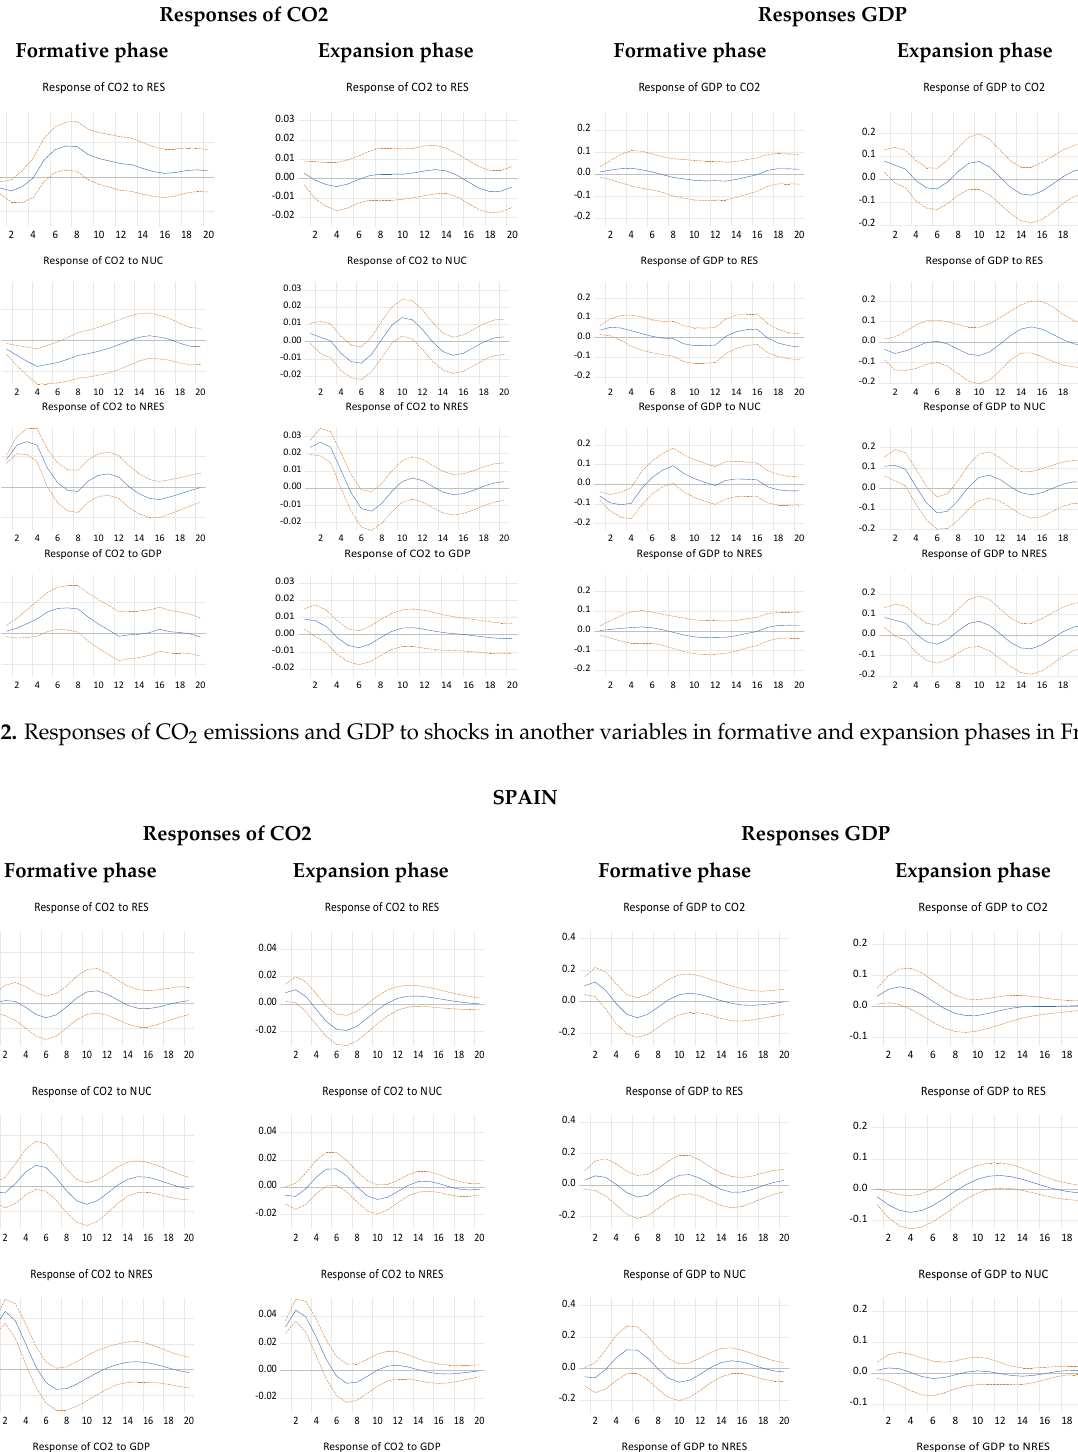
Figure 3. Responses of CO 2 emissions and GDP to shocks in another variables in formative and expansion phases in Spain.